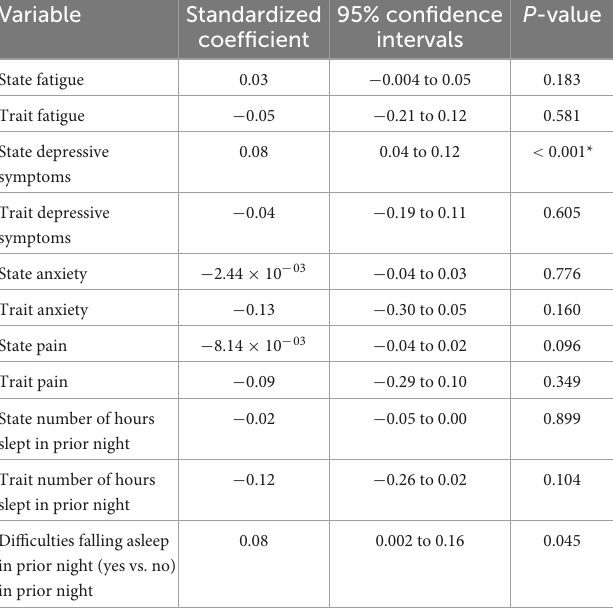
TABLE 5 Model estimates for real-time associations between non-cognitive symptom ratings and mTMT-B performance.